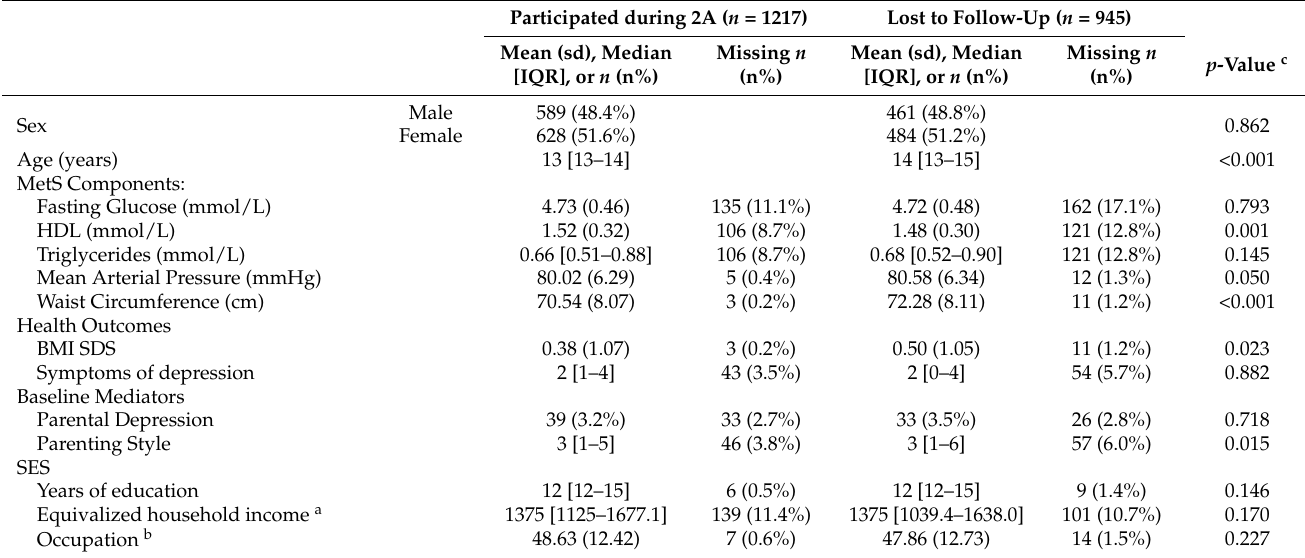
Table 2. Description of the study population at baseline, stratified by those who participated in the second assessment and those who were lost to follow-up and were less than 16 years old.